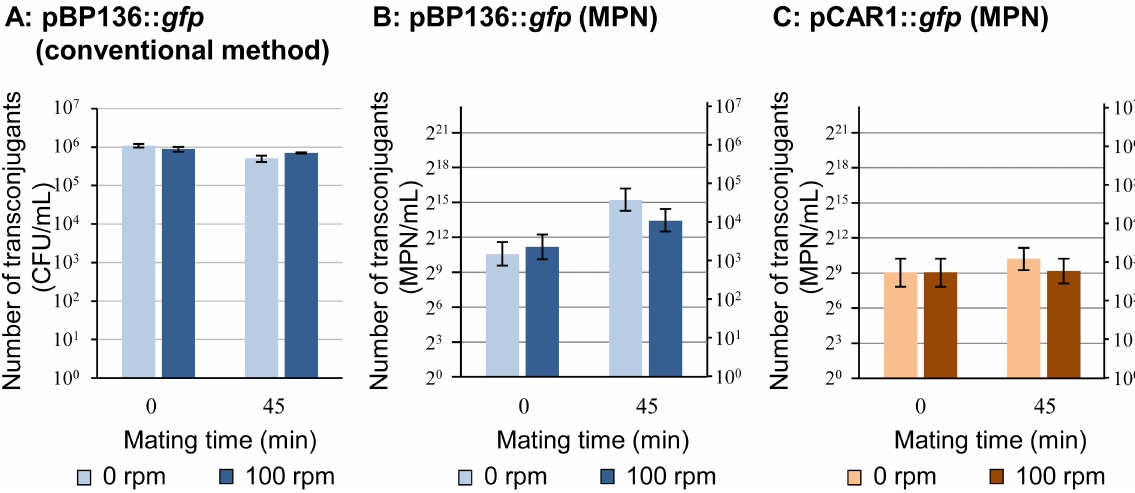
Fig 1. Number of transconjugants of plasmids pBP136:: gfp and pCAR1:: gfp under non-stirring (0 rpm) and stirring (100 rpm) conditions. The numbers were counted by the conventional method of counting their CFU (A) and most probablenumber (MPN) methods (B and C). Becausethe MPN methods were performed with serial dilutionsof the sample (2 0 to 2 24 ’ 10 7.2 ), two logarithmicscales are shownwith bases 2 and 10 (B and C). As a donor, 10 8 CFU/mL of P . putida SMDBS was used and P . putida KT2440RG was used as a recipient. The means of numbers of transconjugants number calculatedfrom triplicate experiments are shown, and standarddeviation(A) or 95% confidencelimits (B and C) are shown as error bars. The raw data of this figure are in S1